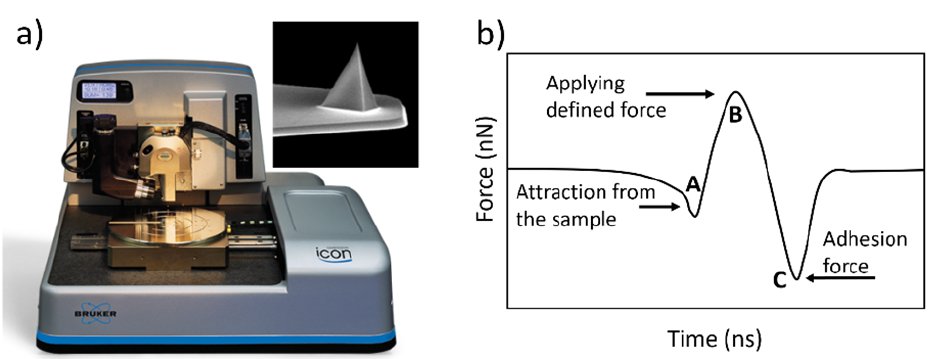
Figure 6. ( a ) Bruker™ “dimension icon” Atomic Force Microscope [15] with the Scanasyst-Air ® probe [16] on the right top corner. ( b ) Typical cycle of force vs. time in the Peak Force Tapping mode.